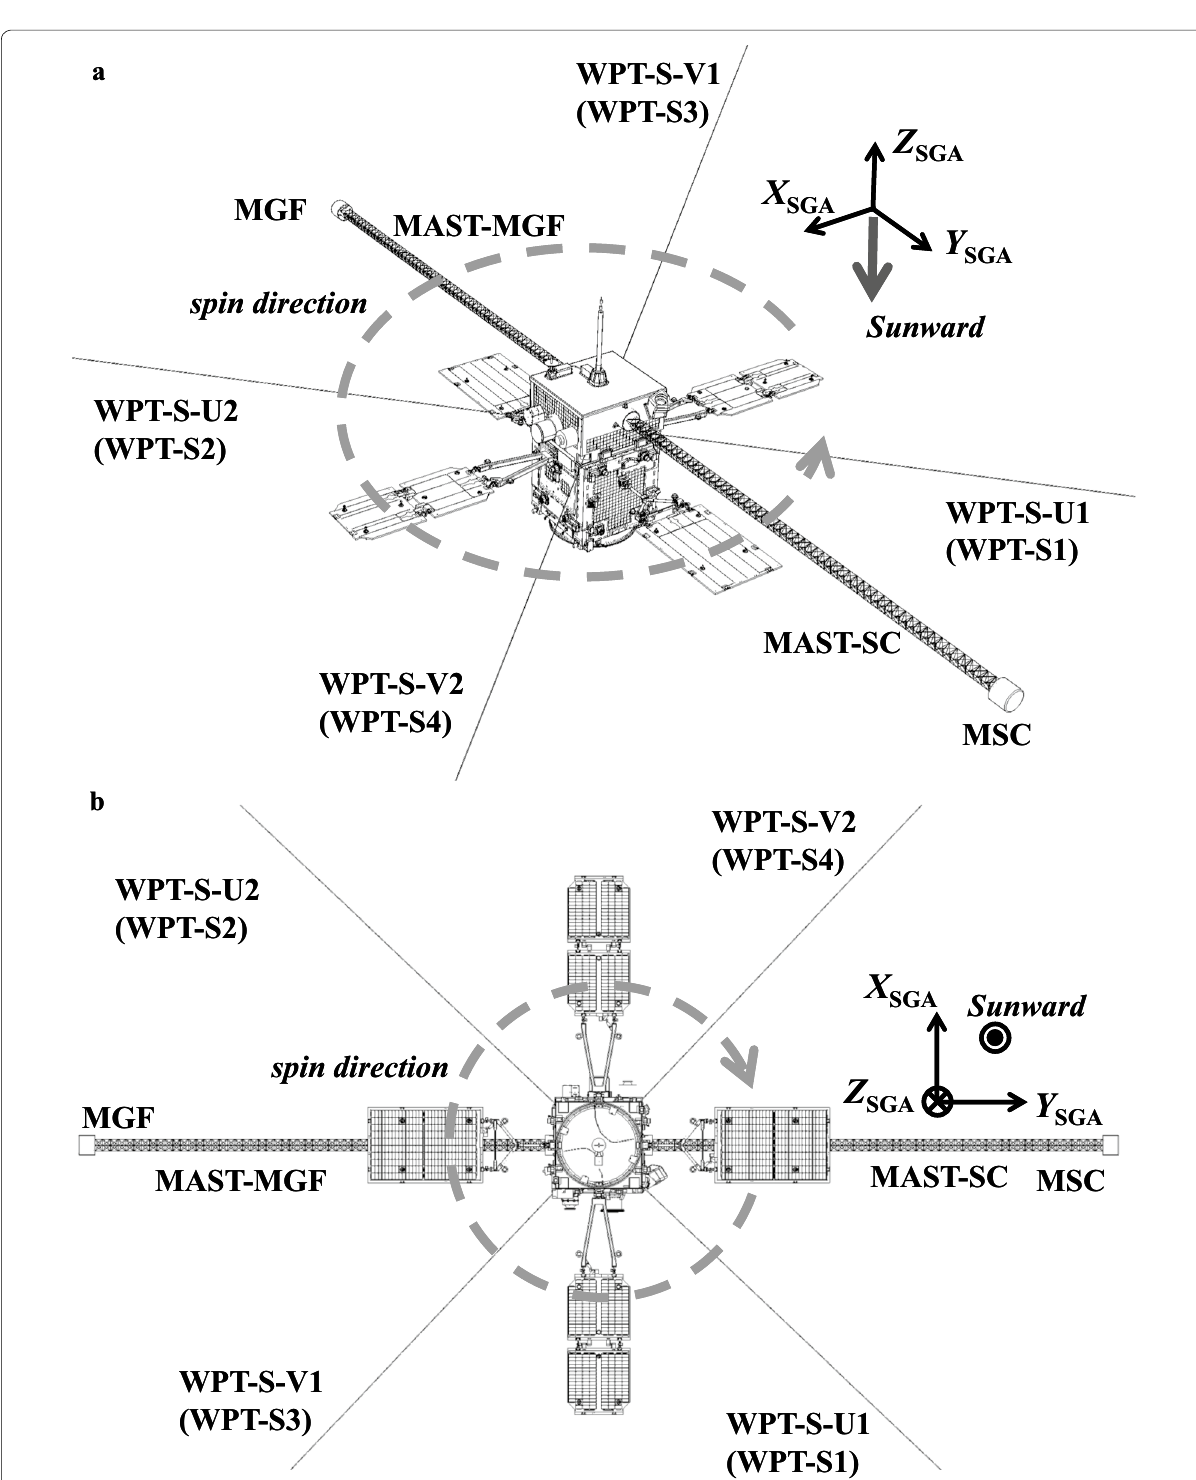
Fig. 1 Overview of the Arase satellite. a External view and b the view from the Z SGA direction, where “SGA” stands for “Spinning Satellite Geometry Axis” coordinates, which represent the geometrical positions of the components on board the satellite. The dashed arrows indicate the direction of spacecraft spin